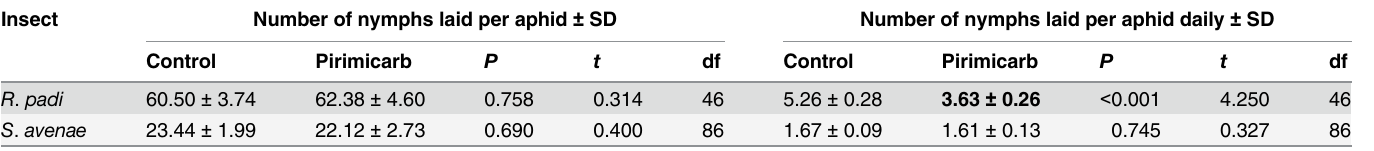
Table 3. Effect of LC 25 of pirimicarb on fecundity of R . padi and S . avenae from the F1 generation.